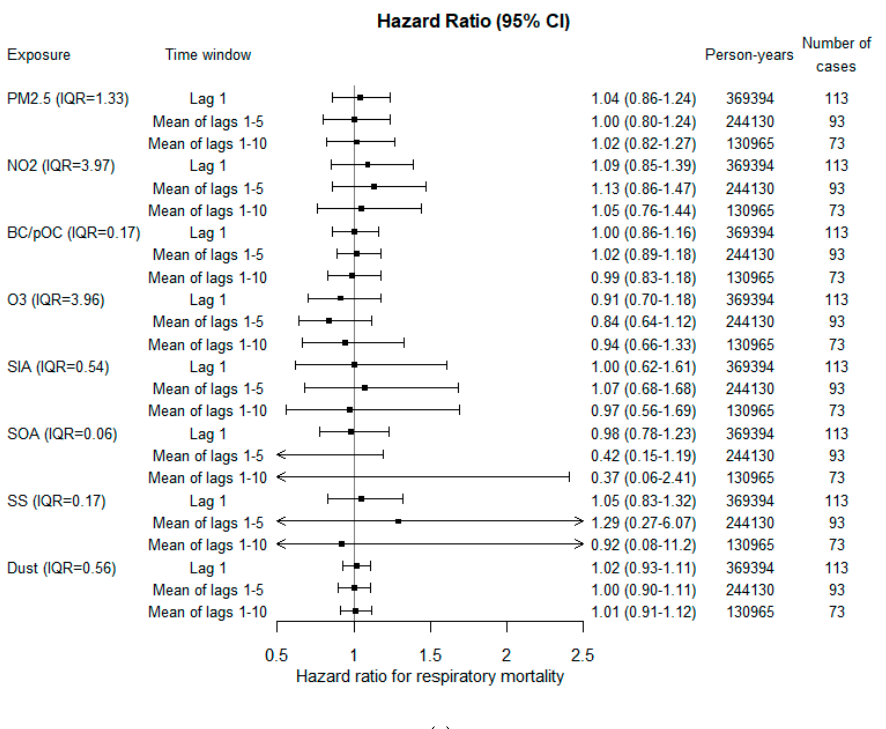
Figure 2. Adjusted hazard ratios for ( a ) natural, ( b ) CVD and ( c ) respiratory mortality per inter-quartile range (IQR). SS = sea salt, SOA = Secondary Organic Aerosols, SIA = Secondary Inorganic Aerosols, O 3 = ozone, BC/pOC = primary emitted Carbonaceous Particles, NO 2 = nitrogen dioxide, and PM 2.5 = particulate matter with aerodynamic diameter ≤ 2.5 µm.